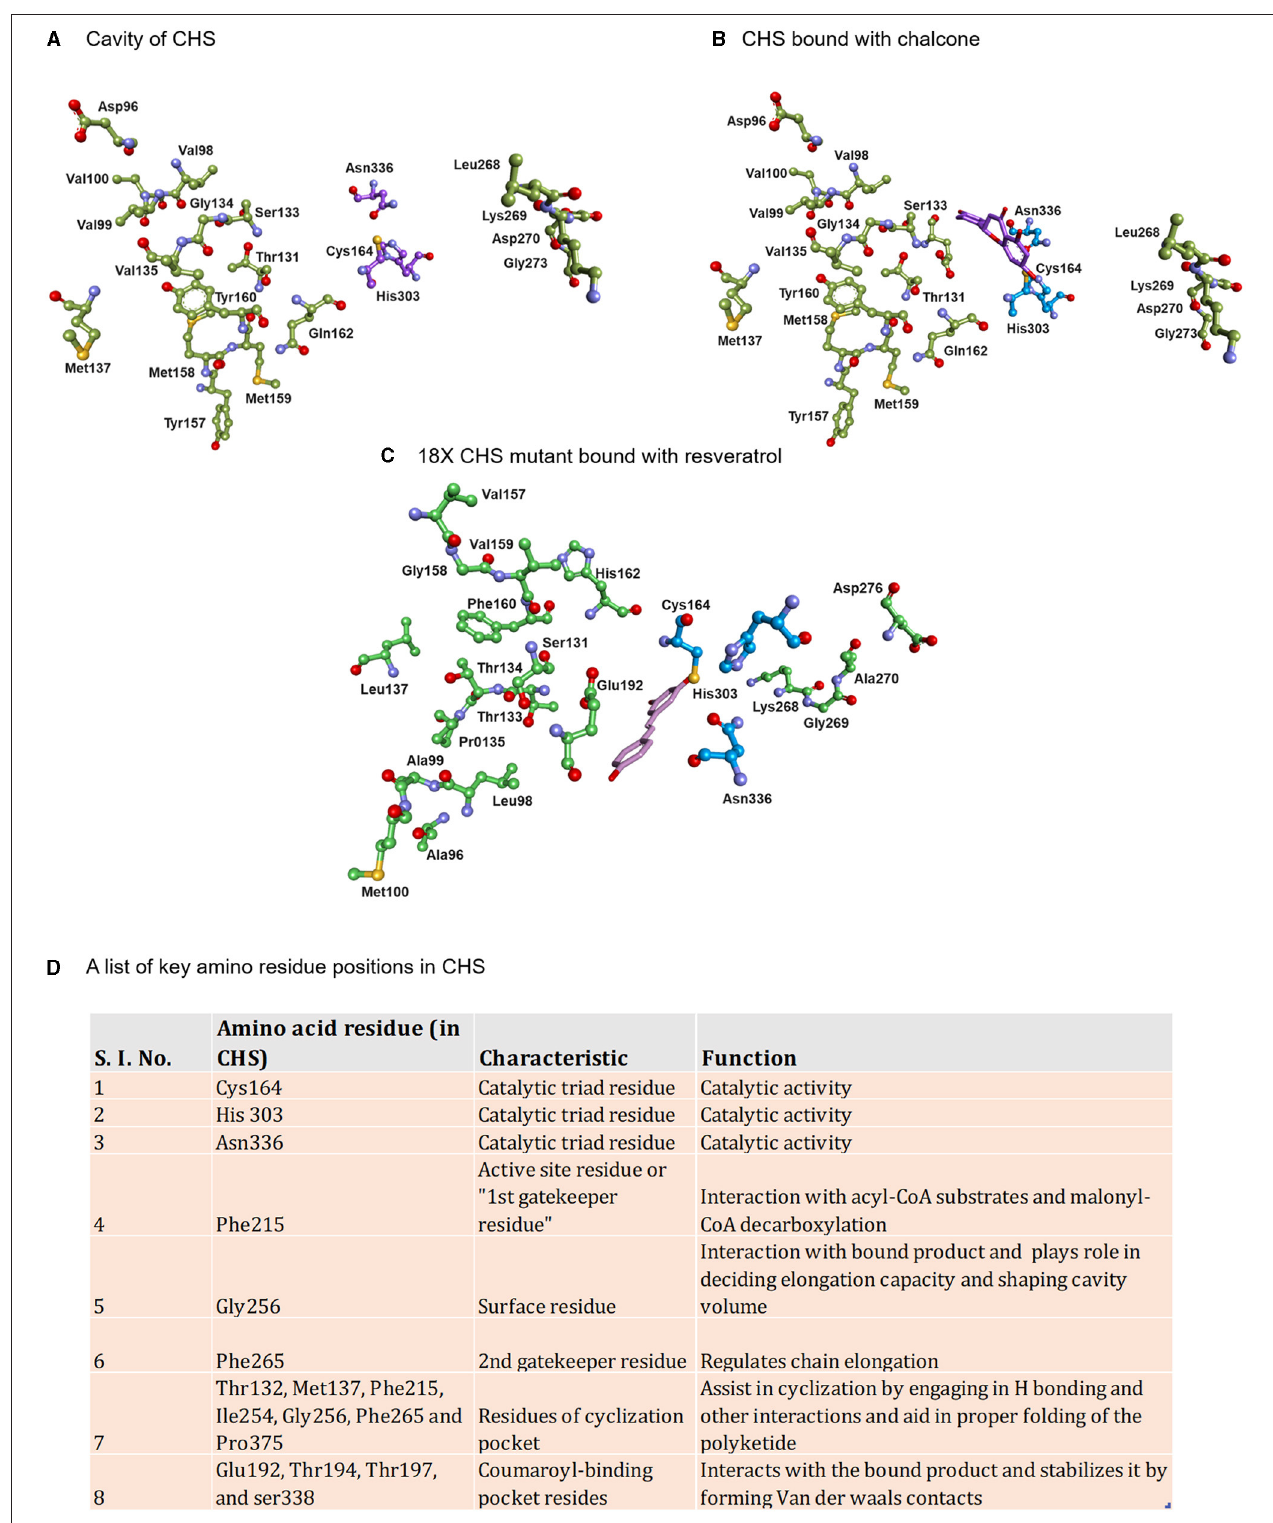
FIGURE 2 | Displaying the active site lining residues of (A) prototype chalcone synthase (B) CHS (docked with chalcone) and (C) 18X mutant of CHS (docked with resveratrol). The key amino residues of CHS are shown in the table along with the models (D) .